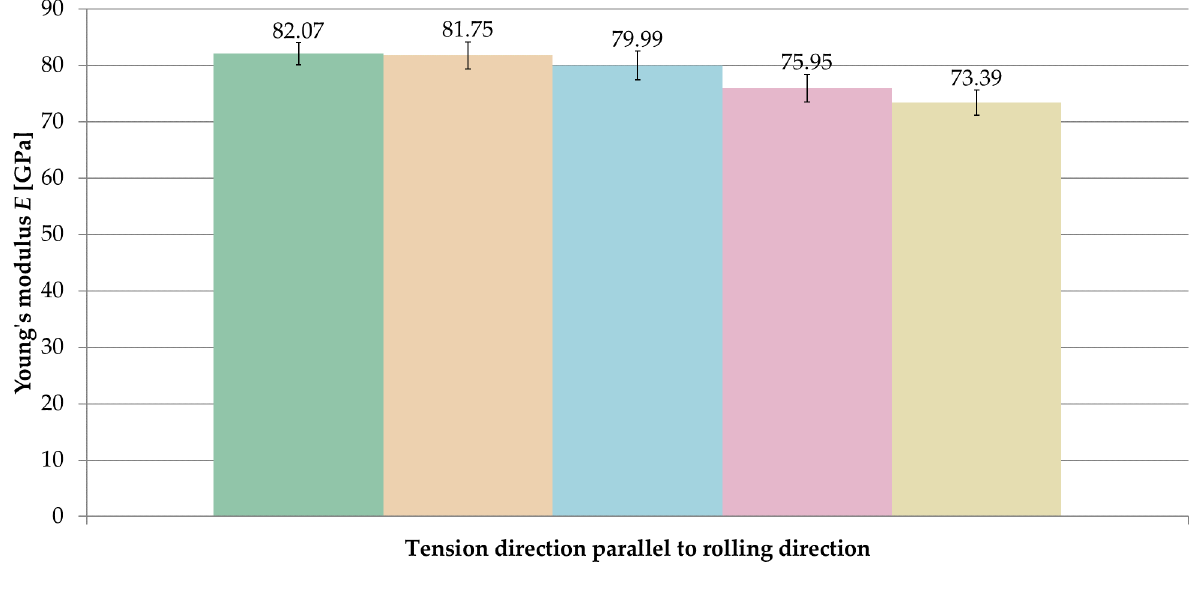
Figure 6. Comparison of Young’s modulus E for samples stretched perpendicular to the rolling direction.